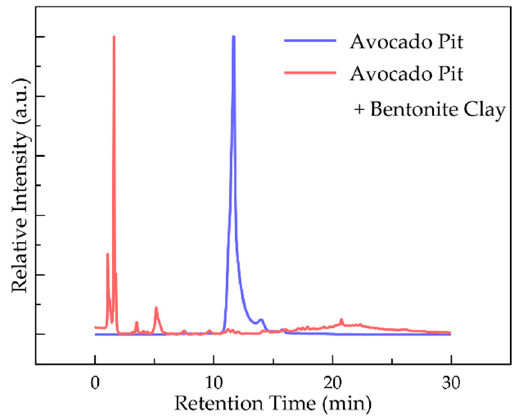
Figure 3. HPLC chromatogram from the HTC process water with avocado pits only and avocado pits + bentonite clay. Concentration of detected compounds are listed in Table S2.